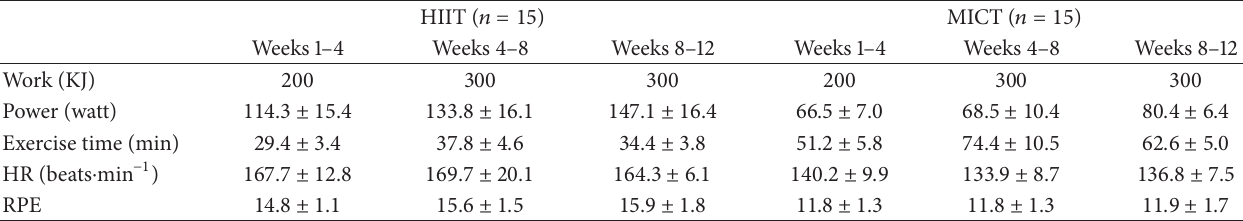
Table 1: The work, power, exercise time, heart rate (HR), and rating of perceived exertion (RPE) of training sessions in every four weeks during the 12-week intervention in HIIE and MICT